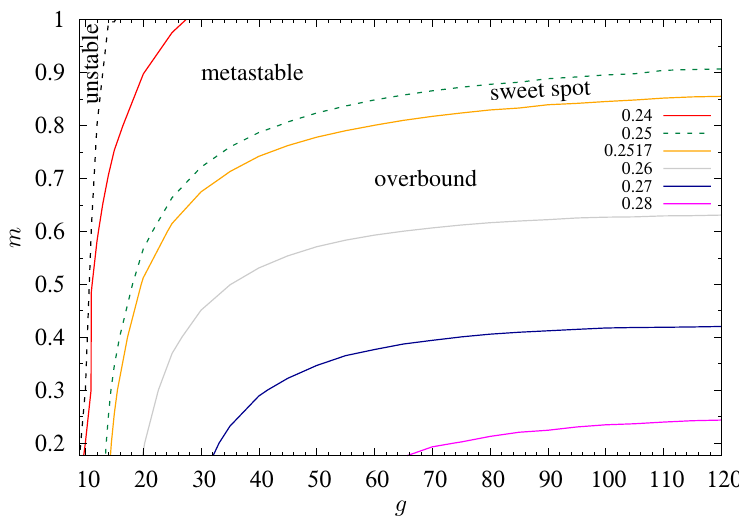
Figure 3 . The ratio m 1 of the static energies of the 1-Skyrmion to the 4-Skyrmion in the ( g; m ) m 4 parameter space. The overbound region (from the orange line and below) means that the classical binding energy is already bigger than the physical data and will only be exacerbated by including the spin quantum correction. The metastable region (between the black and the green dashed lines) means that the 4-Skyrmion could gain energy from breaking up into 4 individual 1-Skyrmions. In the unstable region, the 4-Skyrmion breaks up into two 2-Skyrmions or four 1-Skyrmions without a perturbation. The level sets show the value of the ratio m 1 m 4